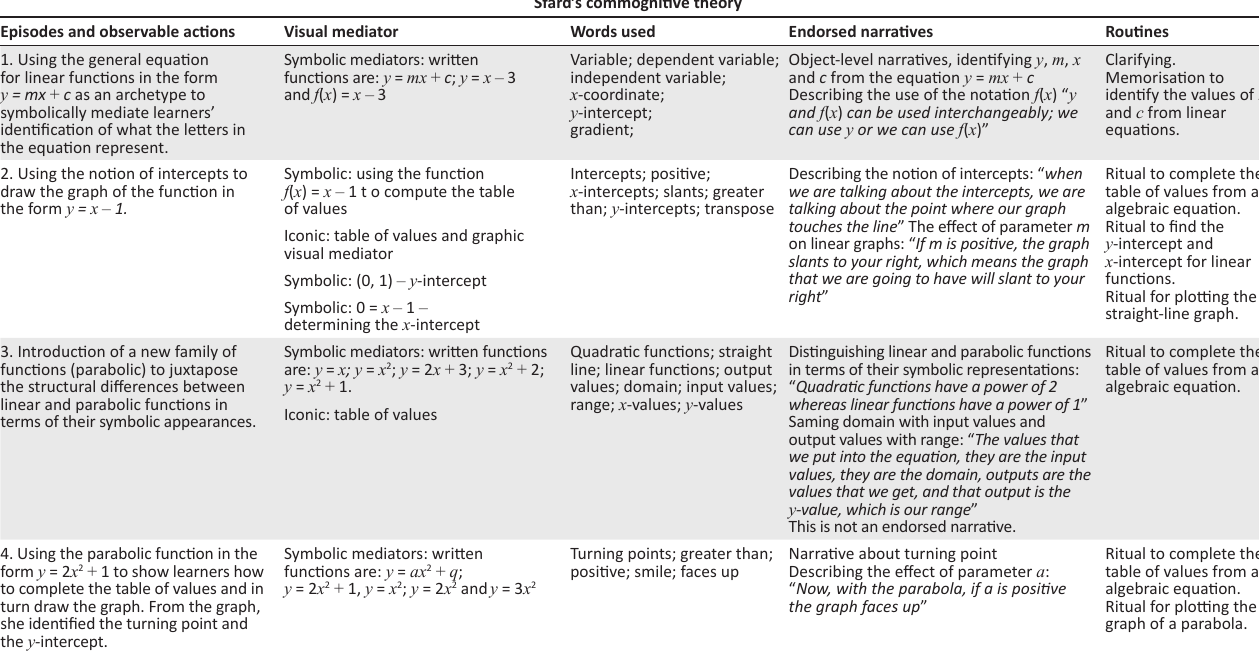
TABLE 3: Discourses in Mutsakisi’s teaching episodes.